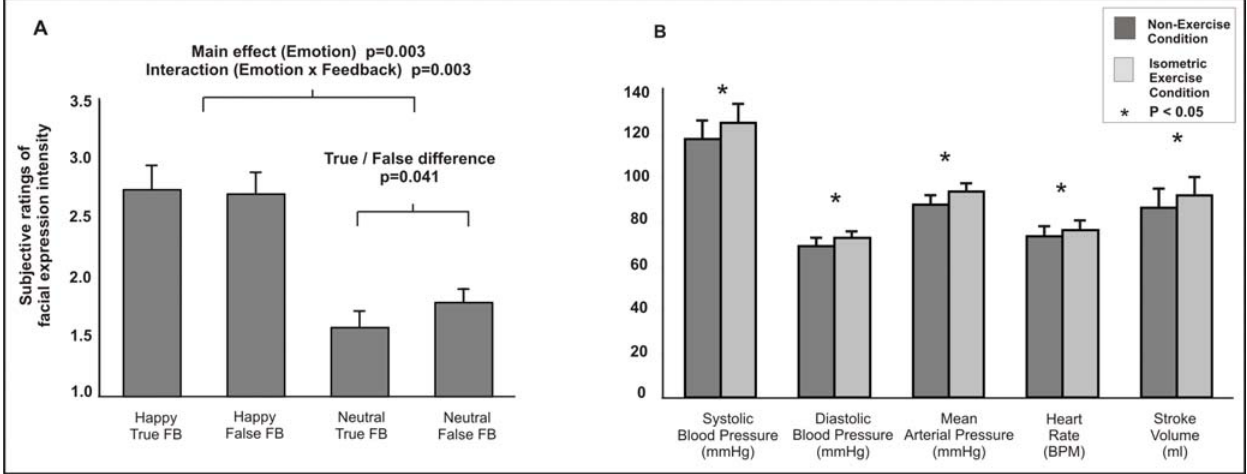
Figure 1. Subjective and physiological responses. (A) Mean subjective intensity ratings of happy and neutral facial expressions during both true and false physiological feedback of cardiac rate. Subjective intensity was rated on a four point rating scale via button box responses during functional scanning. A significant interaction between emotion (happy neutral) and feedback (true false), and a significant increase in the attributed emotional intensity of neutral faces during false relative to true feedback were observed. The volume of partial brain T2 data acquired is illustrated by the dashed box. (B) Peripheral physiological measures recorded outside the scanner showed that exercise increased systolic, diastolic, and mean arterial pressure, heart rate and stroke